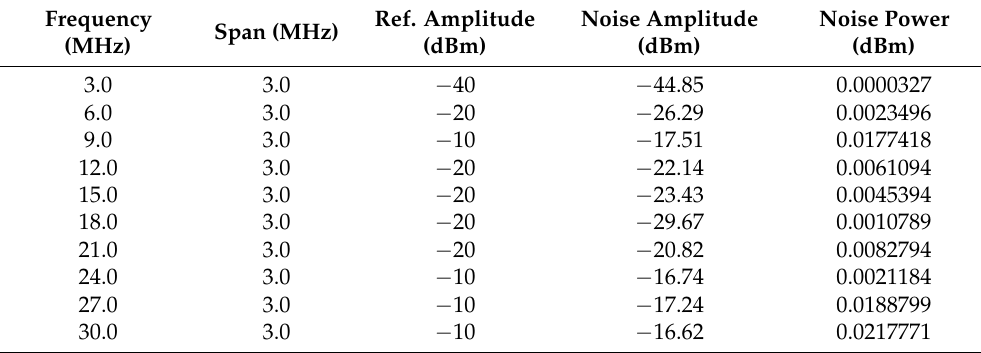
Table 3. Electric Iron frequency domain noise amplitude and